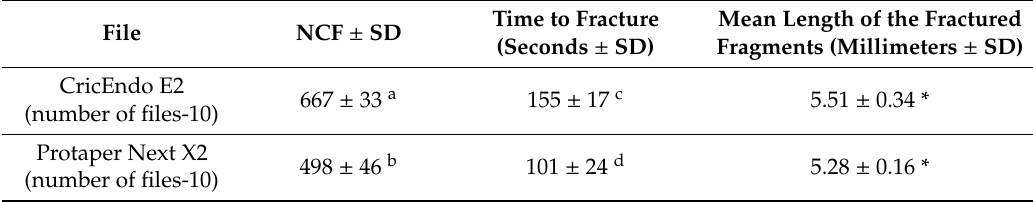
Table 1. Data obtained after cyclic fatigue test.